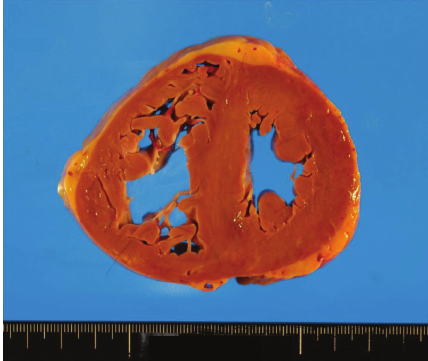
Figure 1: Transverse section of the heart showing marked hypertrophy of the right ventricle with a wall thickness of 7 mm. The interventricular septum is straight, giving a “D-” shaped morphology of the left ventricle, characteristic of severe